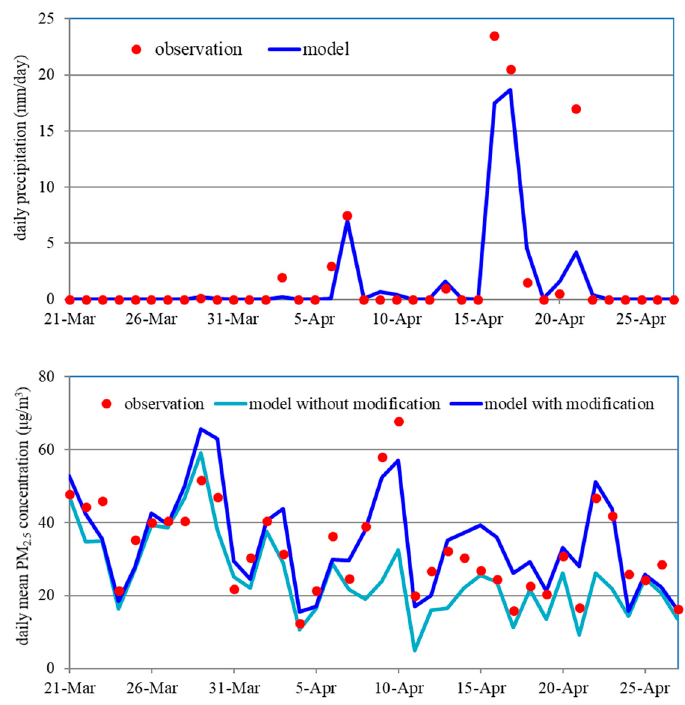
Figure 6. Modeled and observed daily precipitation ( top ) and daily mean PM 2.5 concentrations ( bottom ) at Seoul.